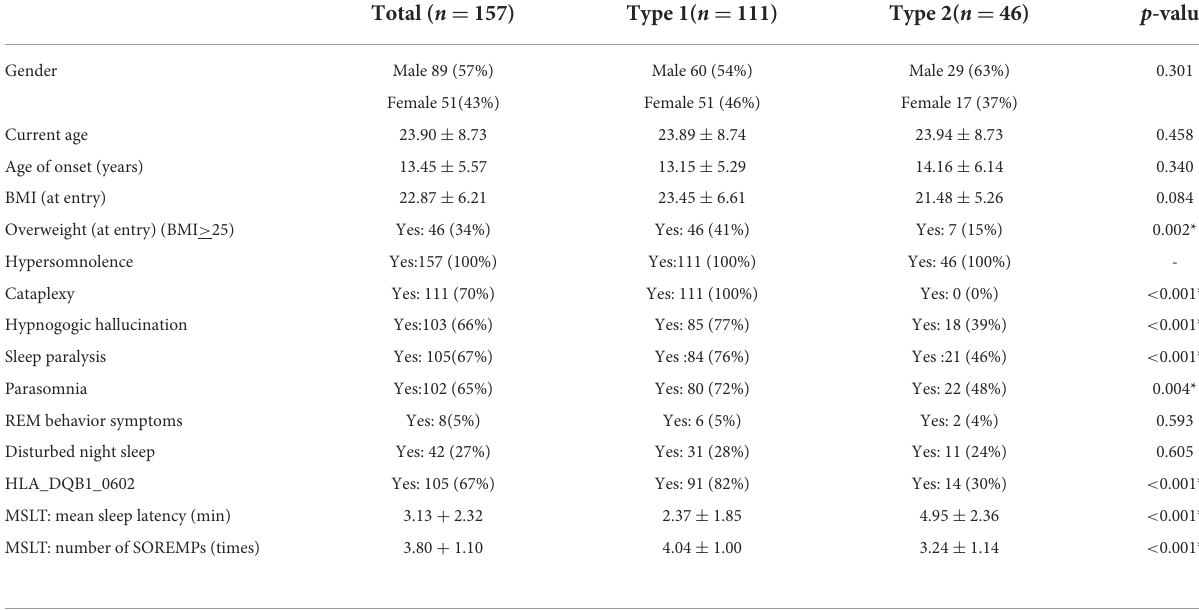
TABLE 1A Demographic and clinical data of narcolepsy type 1, narcolepsy type 2, and total